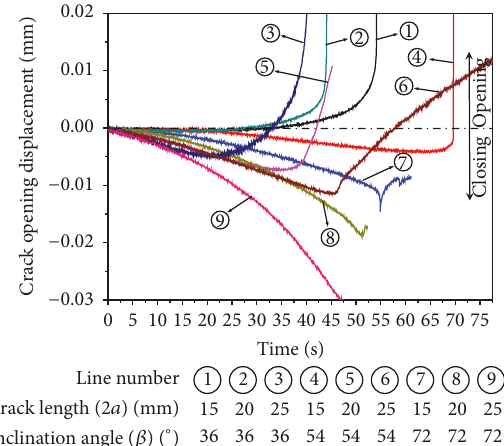
Figure 9: Crack opening displacement for the specimens with preexisting cracks oriented at 36 ∘ , 54 ∘ , and 72 ∘ .